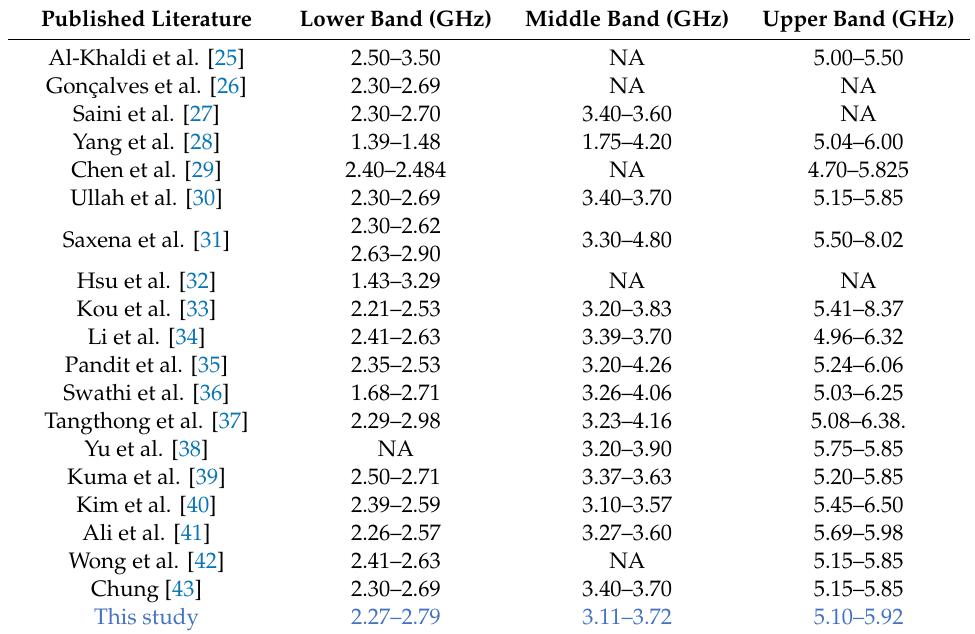
Table 3. Comparison of the proposed antenna with previously proposed antennas in terms of supported frequency